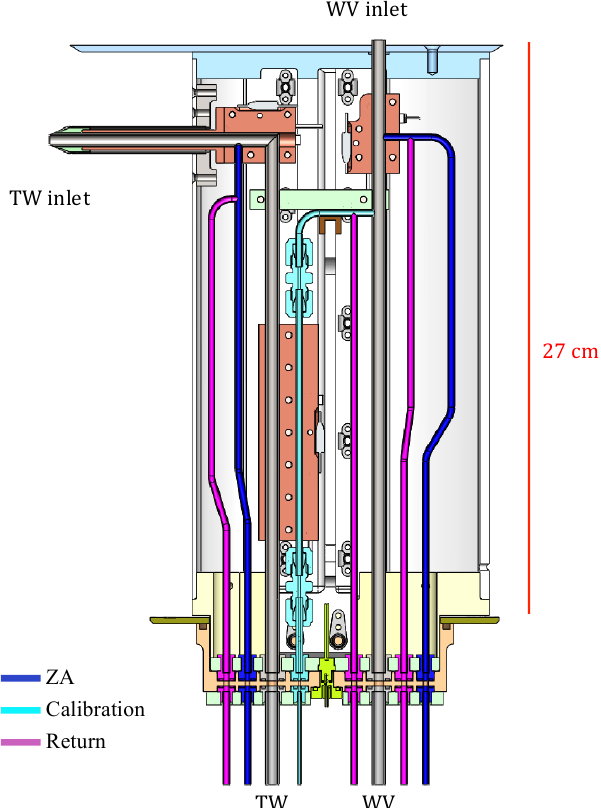
Figure 5. Schematic of the NOAA Water instrument inlet pylon showing the WV and TW sample inlet tubes, the inlet line and cat- alyst heater blocks (orange), the zero air (ZA) delivery lines (blue) to each inlet, the Pt catalyst and calibration delivery line (cyan) to the WV inlet, and the ZA and calibration return lines (magenta).